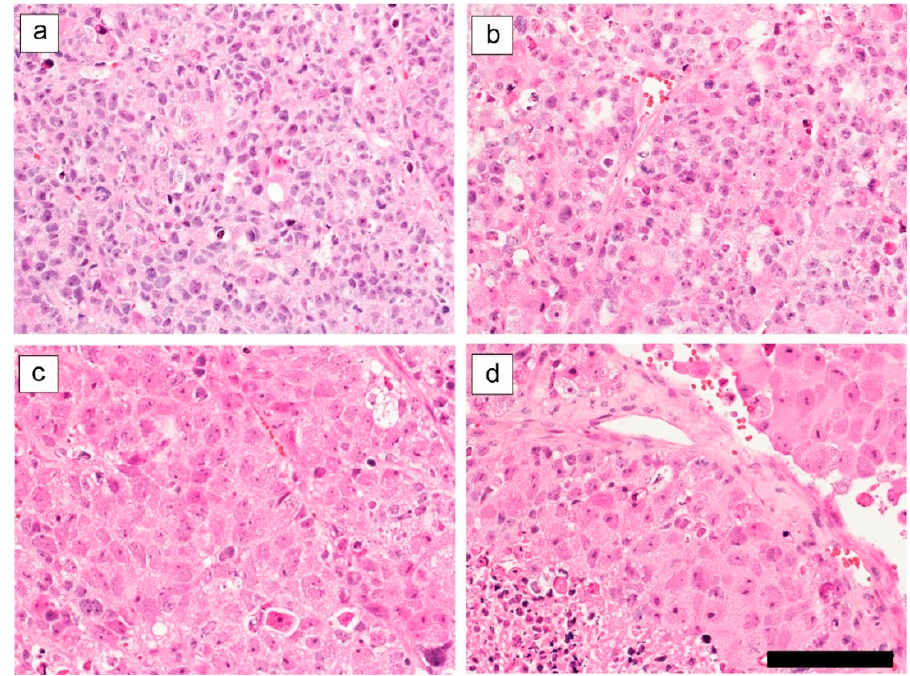
Figure 3. Tumor specimen histology across distinct treatment groups (400 × magnification, scale bar: 100 µ m). ( a ) Control group; ( b ) Cisplatin-only group; ( c ) RIT-only group; ( d ) Combination therapy group.